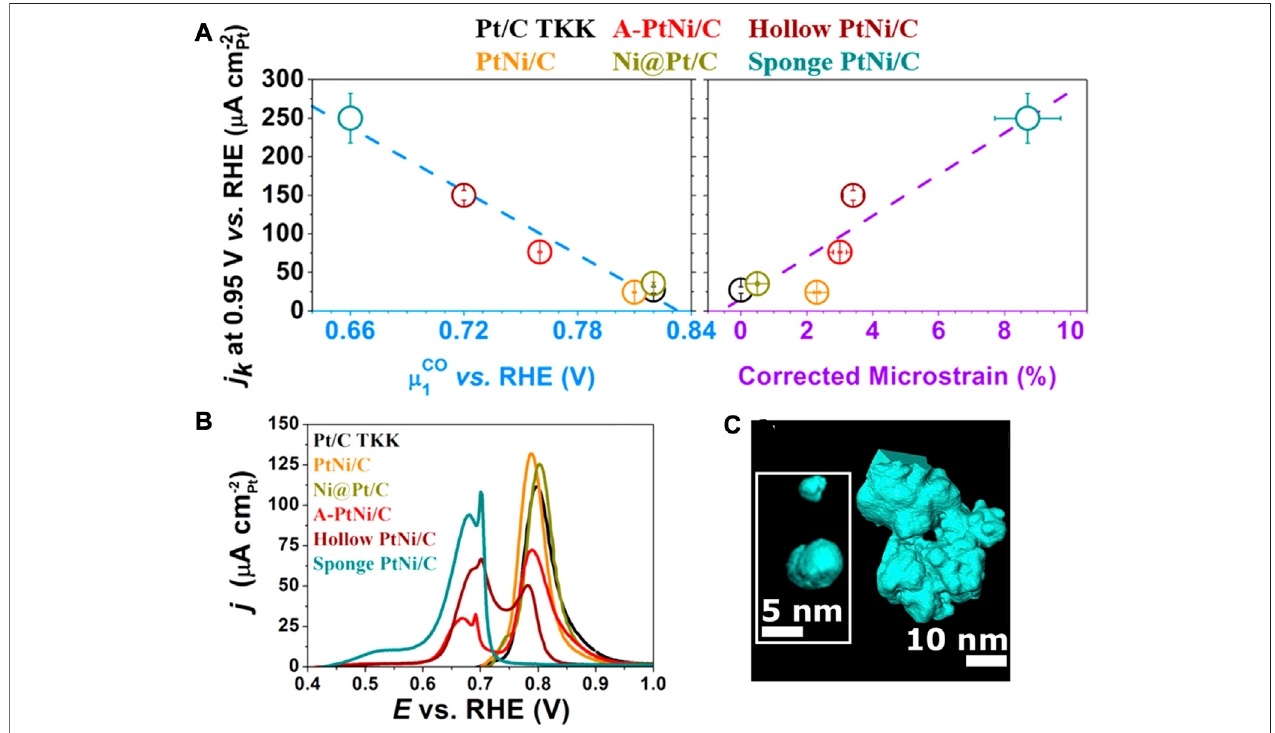
FIGURE16|(A) RelationshipbetweentheCOaverageoxidationpotential, SD,andORRintrinsicactivecurrent. (B) COoxidation curvesofdifferentnanoparticles. (C) Tomography simulation of Pt/C nanoparticles. (A,B) Reproduced with permission (Chattot et al., 2017). Copyright 2017, American Chemical Society.